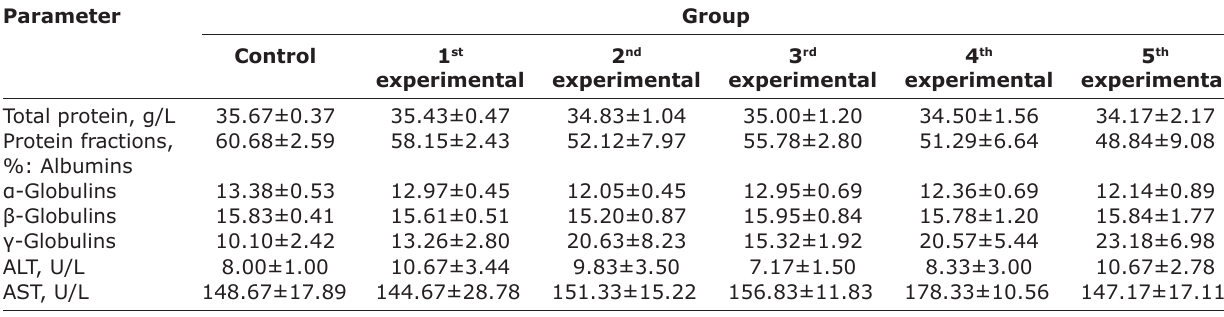
Table-2: Biochemical parameters of the blood of broiler chickens, characterizing protein metabolism. Parameter